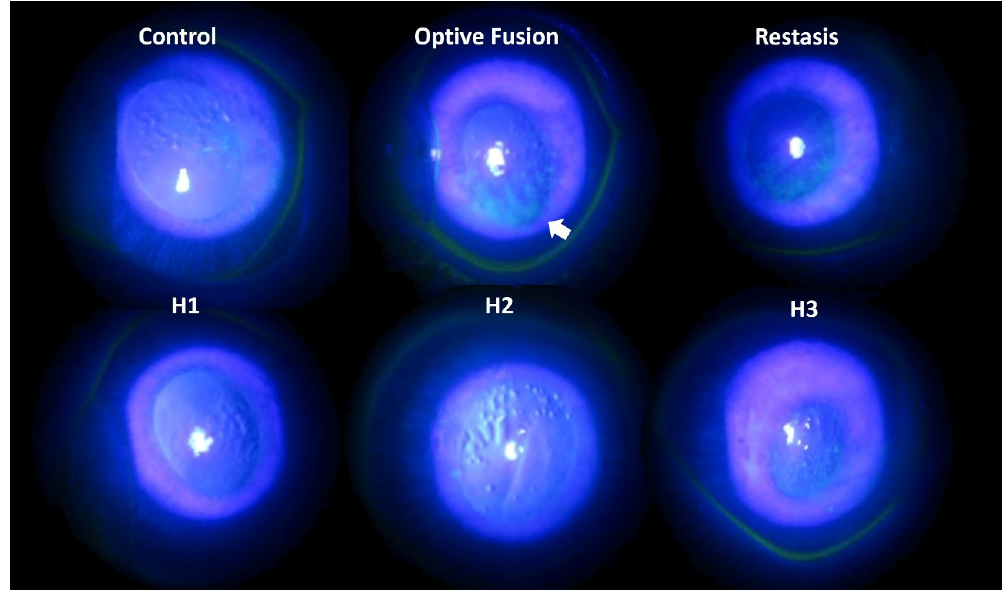
Figure 3. Representative images of corneal fluorescein staining for each group after DES induction with BAC and treatment.